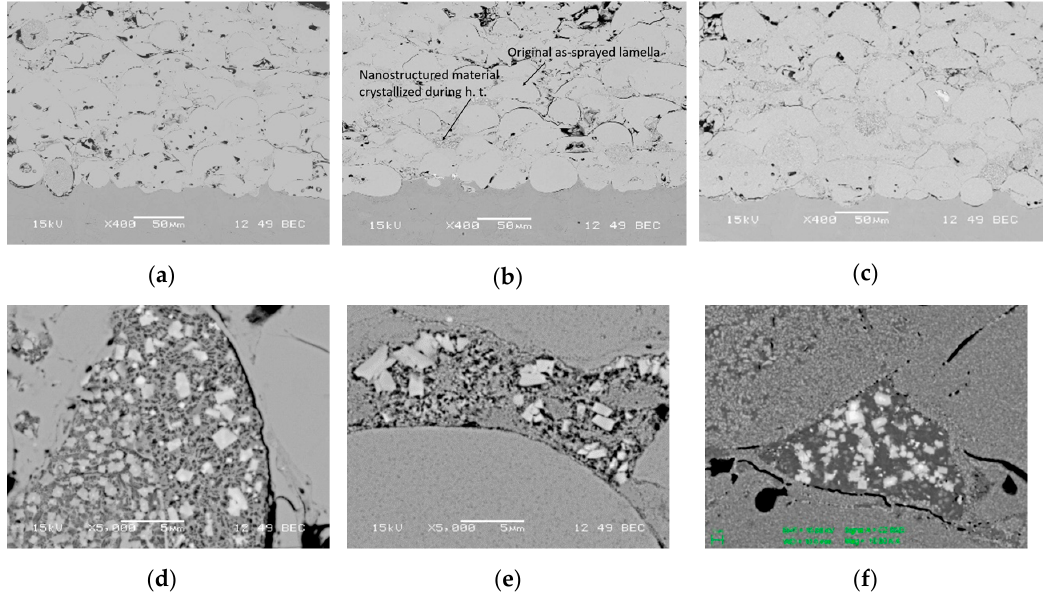
Figure 8 . SEM micrographs of CGS coatings after Kalling’s etching: ( a , d ) heat-treated at 650 °C; ( b , e ) heat-treated at 750 °C; and ( c , f ) heat-treated at 850 °C for 90 min. Original rounded or flattened light-colored lamellae and dark-colored regions, crystallized during heat treatment, can be recognized.